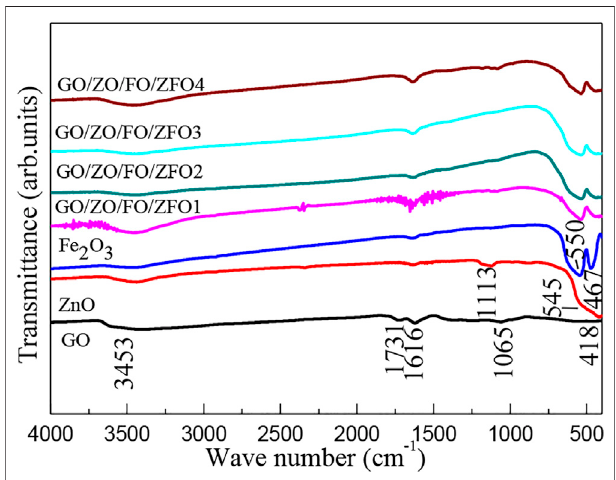
FIGURE 3 | FTIR spectra of samples GO, ZnO, Fe 2 O 3 , GO/ZO/FO/ ZFO1, GO/ZO/FO/ZFO2, GO/ZO/FO/ZFO3, and GO/ZO/FO/ZFO4.